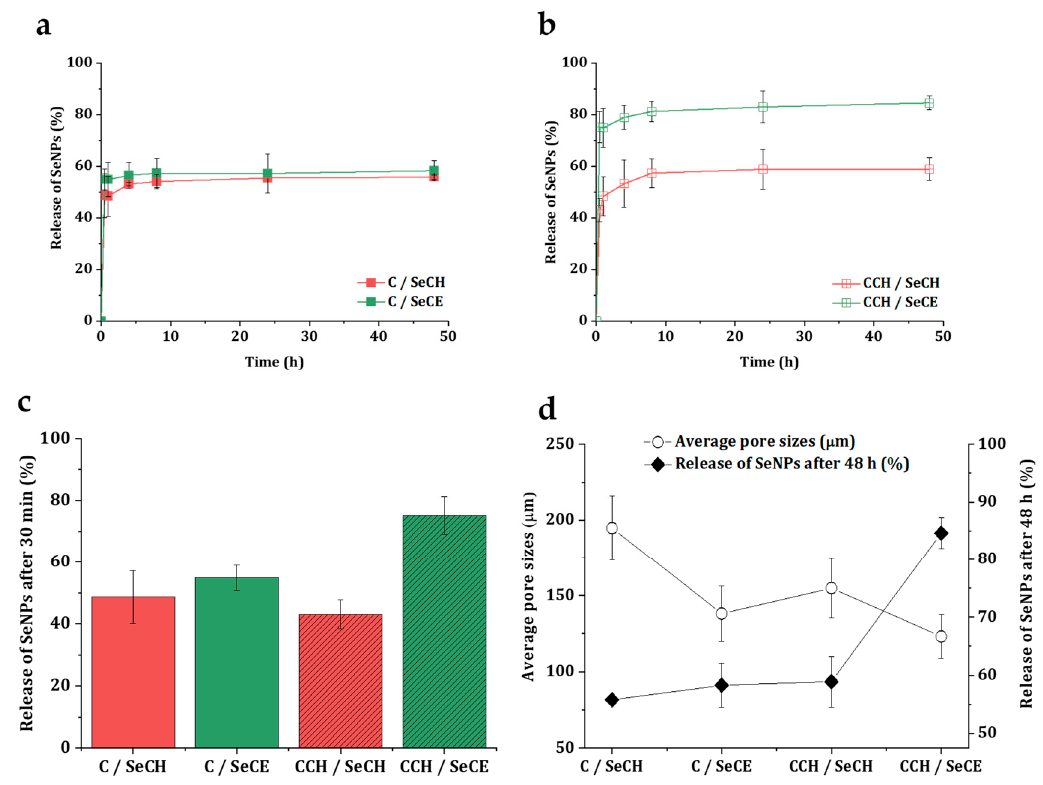
Figure 8. Percentage of release of both types of used SeNPs from the C-based ( a ) and CCH-based ( b ) scaffolds. Summary of the total number of released SeNPs after 30 min ( c ). Comparison of the trends of the average pore sizes with the total number of released SeNPs after 48 h ( d ).